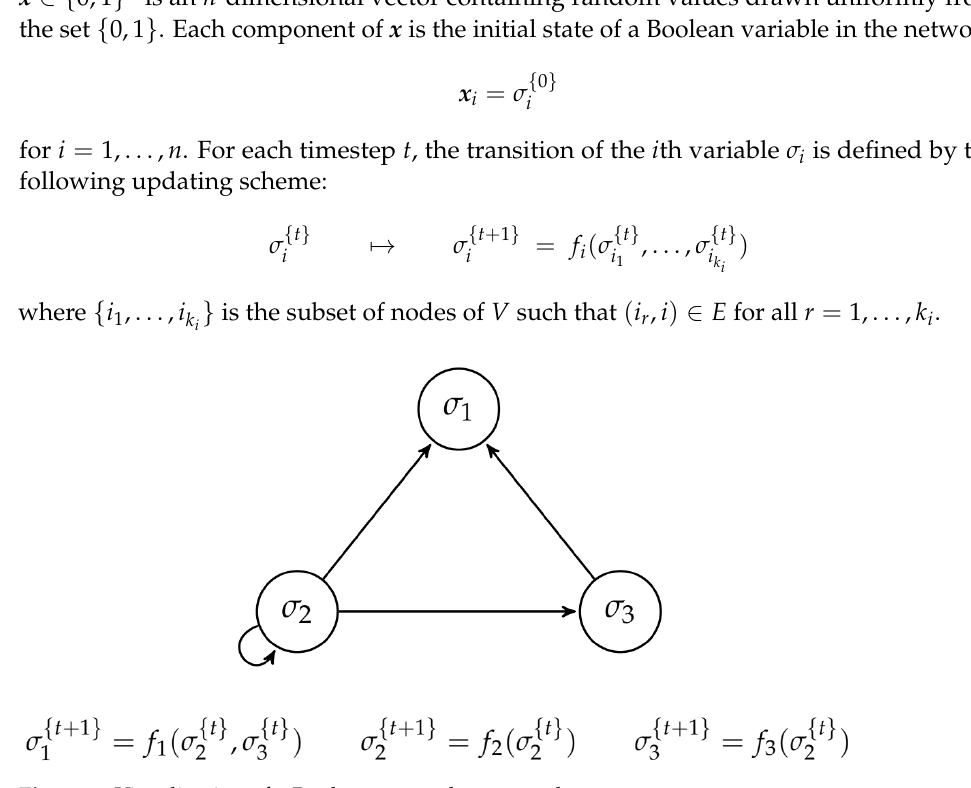
Figure 1. Visualization of a Boolean network as a